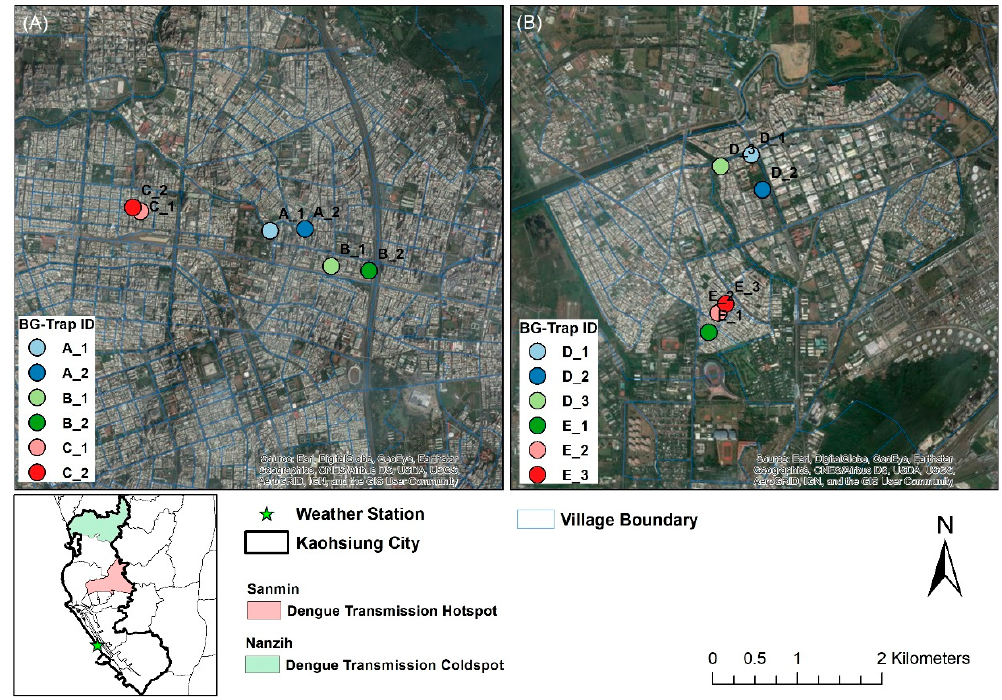
Figure 1. Study Locations. ( A ) Sanmin—dengue transmission hotspot ( B ) Nanzih—dengue transmission coldspot. The small map shows the location of Kaohsiung City, southern Taiwan, and also Sanmin and Nanzih districts.